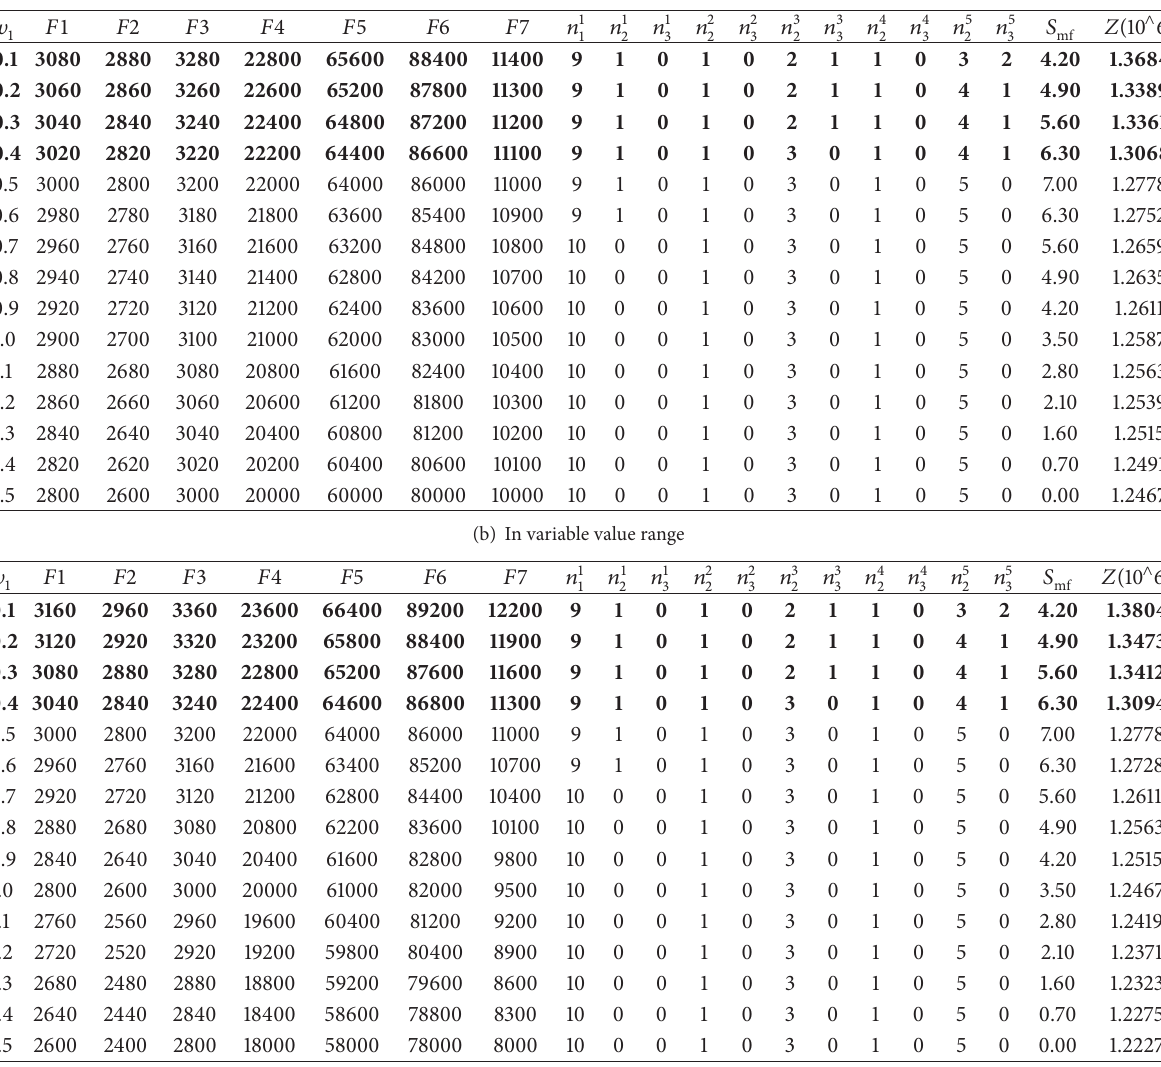
Table 3: Computation results of the trains flow distribution model. (a) In original value